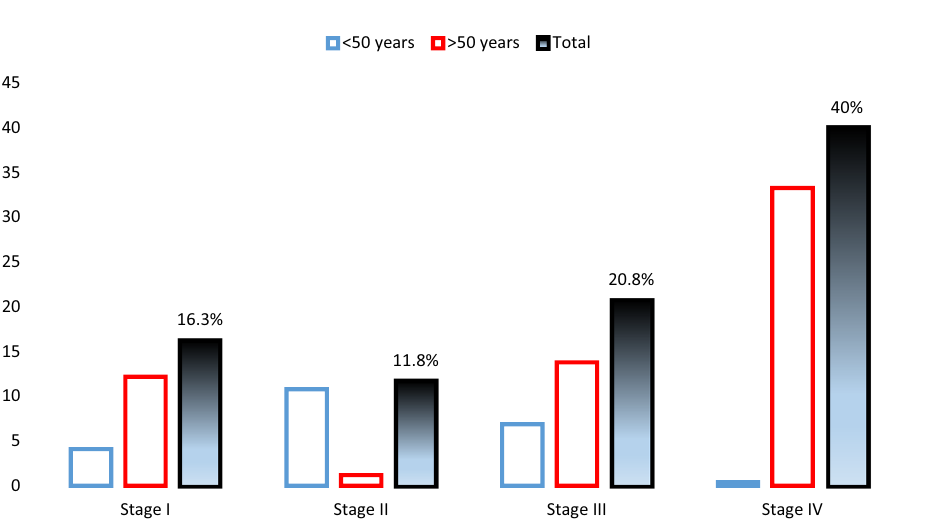
Table 2. Comparison of clinical characteristics related to HIV. Bold value indicates level of significance for statistical analyses set at P < 0.05. ART antiretroviral therapy. a Mean ± SD.